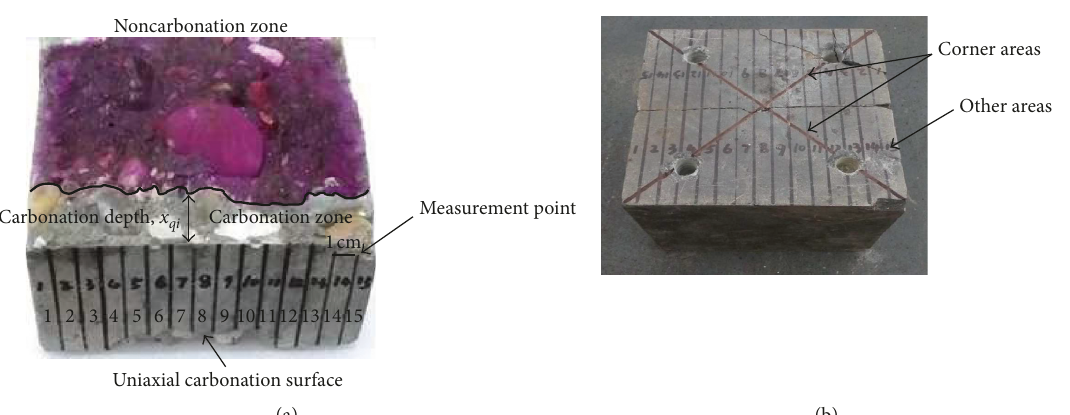
Figure 9: Carbonation schematic diagram: (a) carbonation measurement point and (b) the position of the corner areas and other